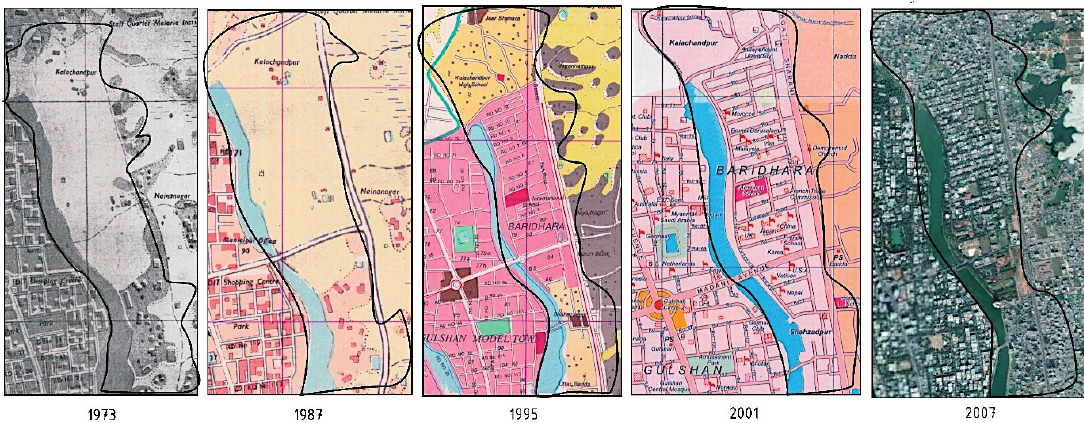
Figure A2. Base maps of ward 18 (Baridhara) for syntactic analysis (not to scale). Source: Survey of Bangladesh and Google Earth Image, 2007.